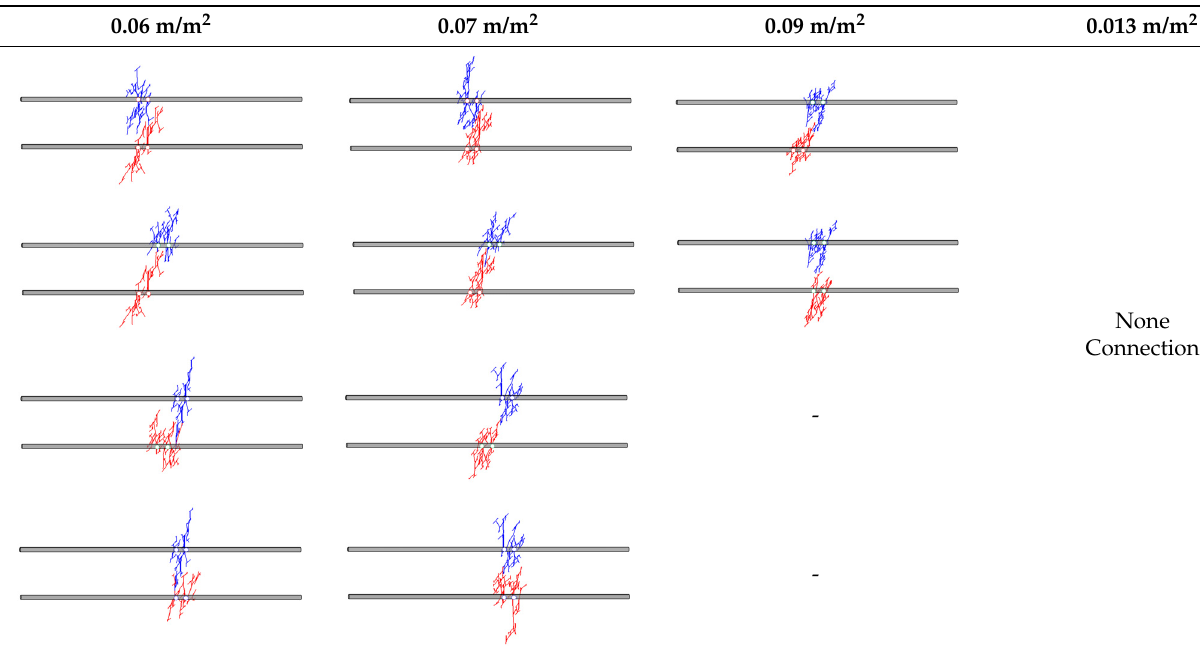
Table 4. Inter-well frac/frac connections for different NF densities.